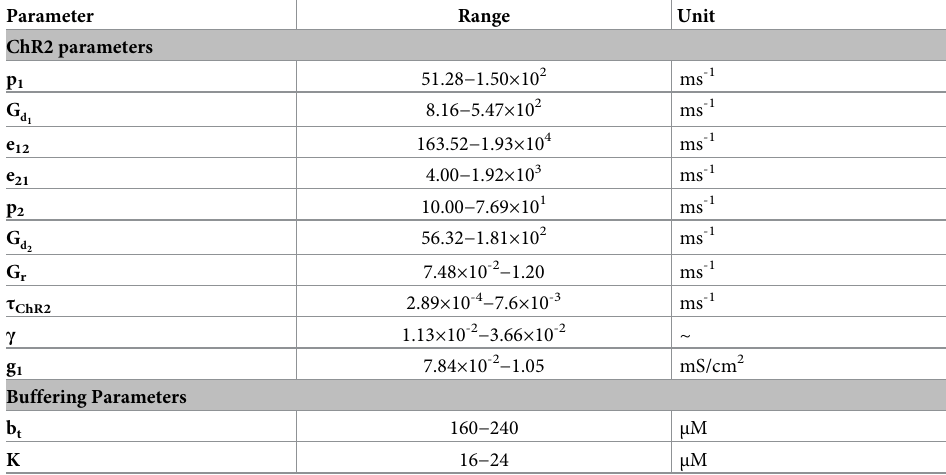
Table 2. Range of parameters for global sensitivity